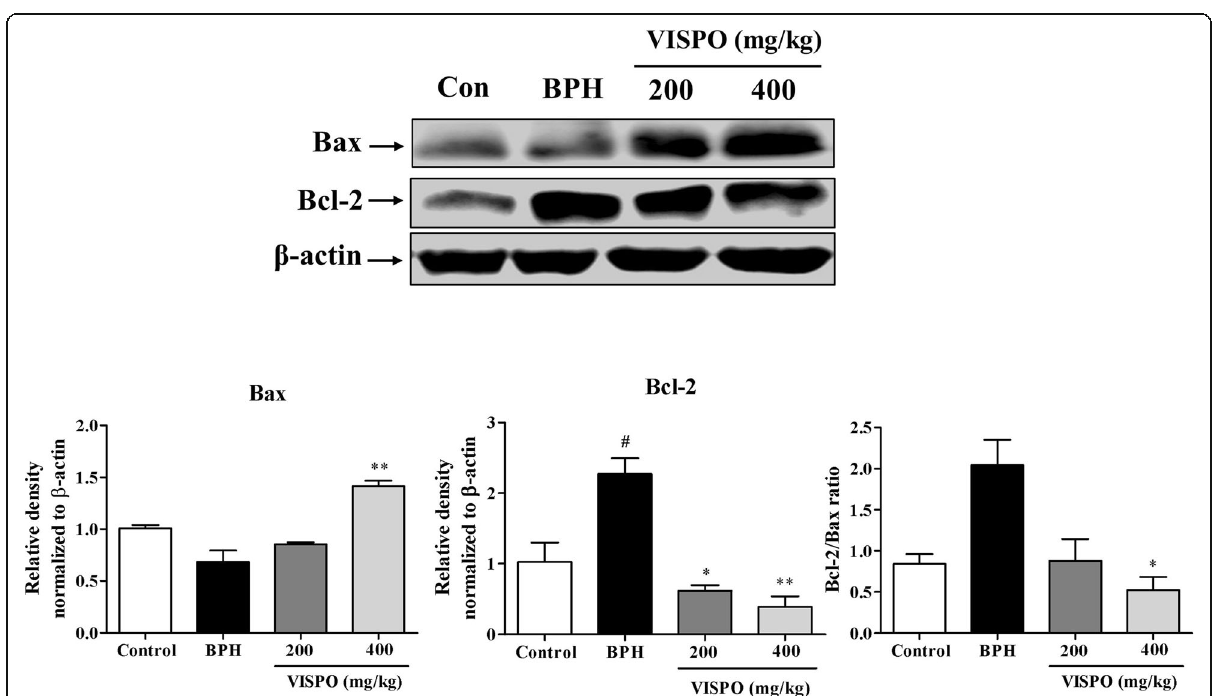
Fig. 7 Effect of VISPO administration on the expression of Bcl-2 family in prostate tissue of BPH model rats. The protein expression was determined by western blotting using specific antibodies. β -actin was used as loading control. Densitometric analysis was performed using